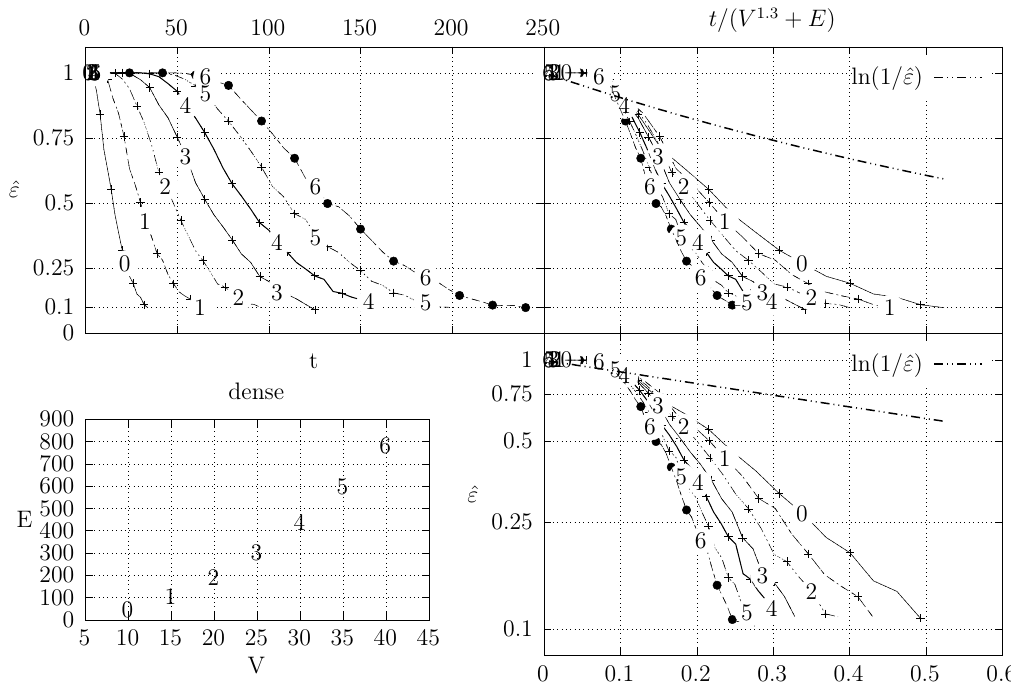
Figure 20. Estimation of variation distance as a function of the number of iterations for dense graphs (see Section 4.3.1 for details).